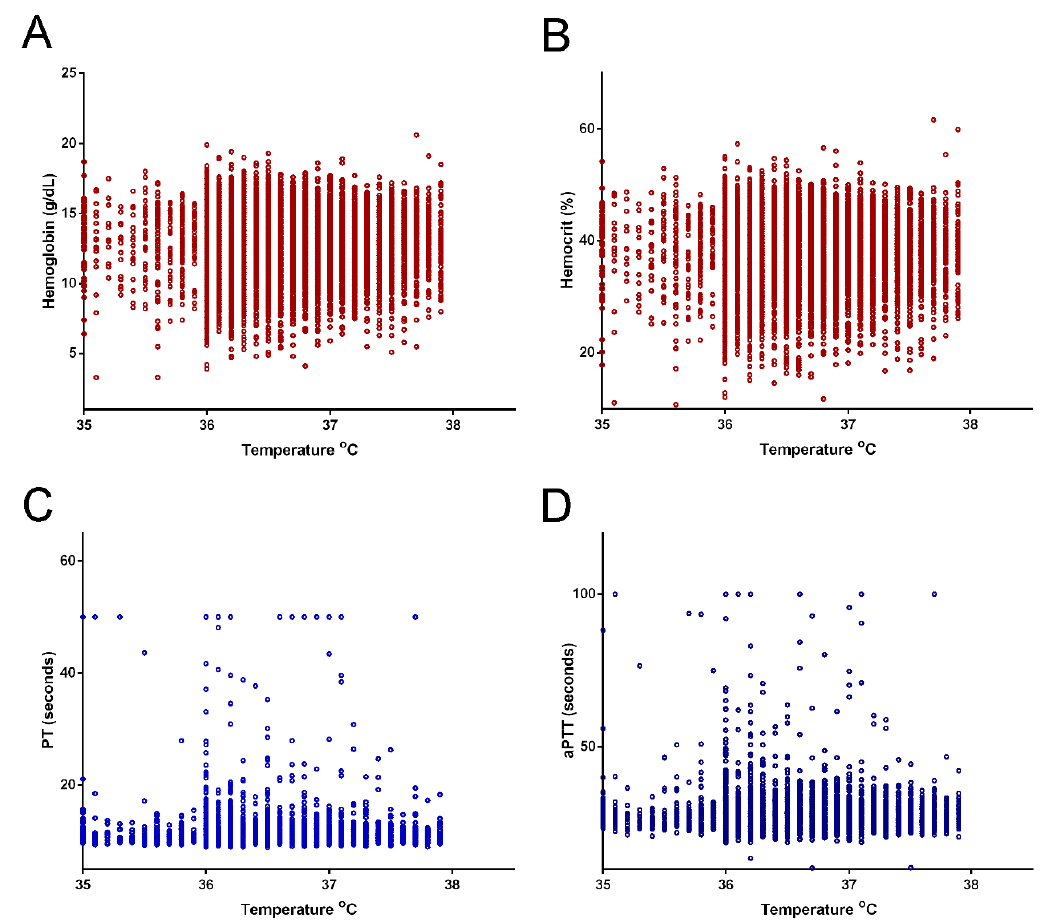
Figure 2. Pearson correlation of levels of hemoglobin (Hb) ( A ), hematocrit (Hct) ( B ), prothrombin time (PT) ( C ), and activated partial thromboplastin time (aPTT) ( D ) to the body temperature.